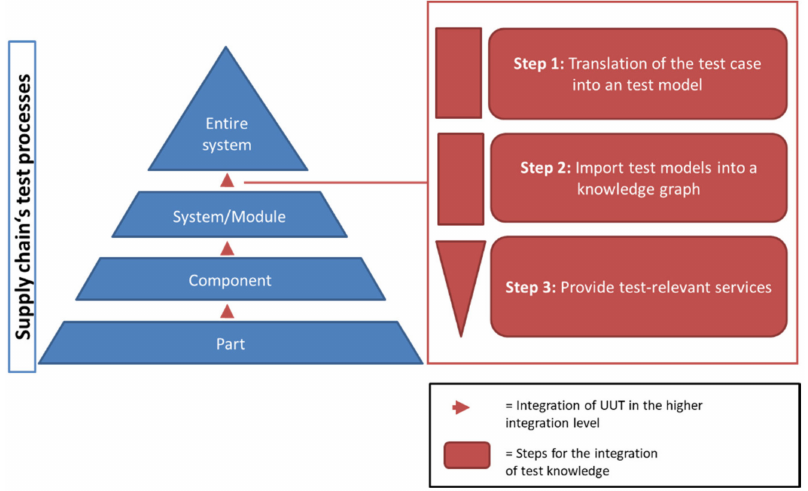
Figure 5. Extraction and integration of test knowledge into the supply chain test